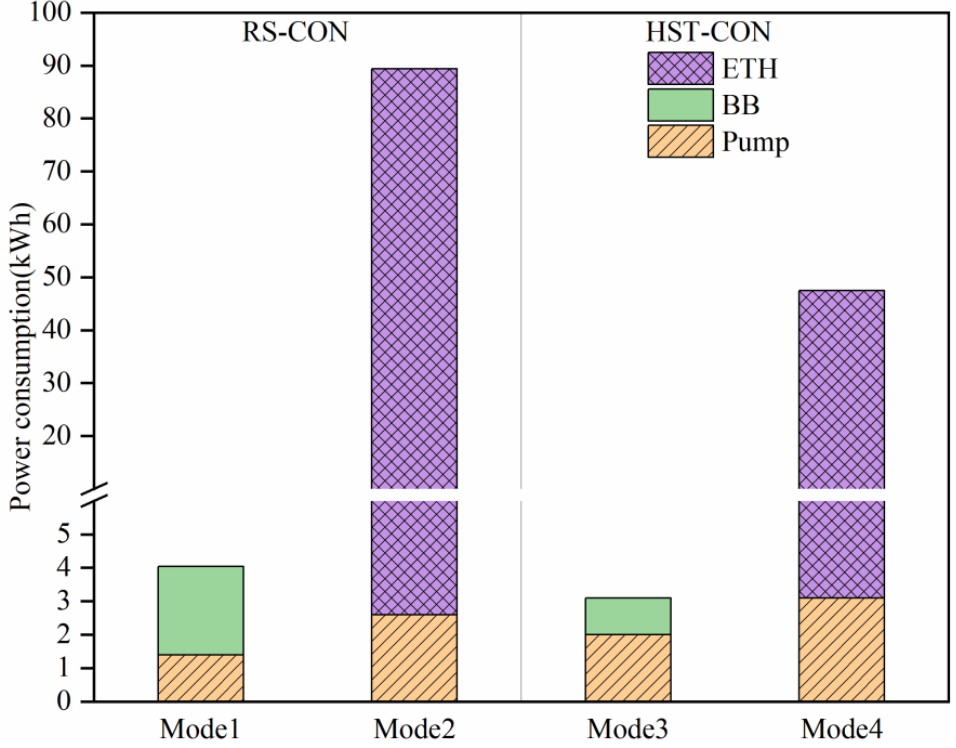
Figure 6. Power consumption under different heating control strategies.